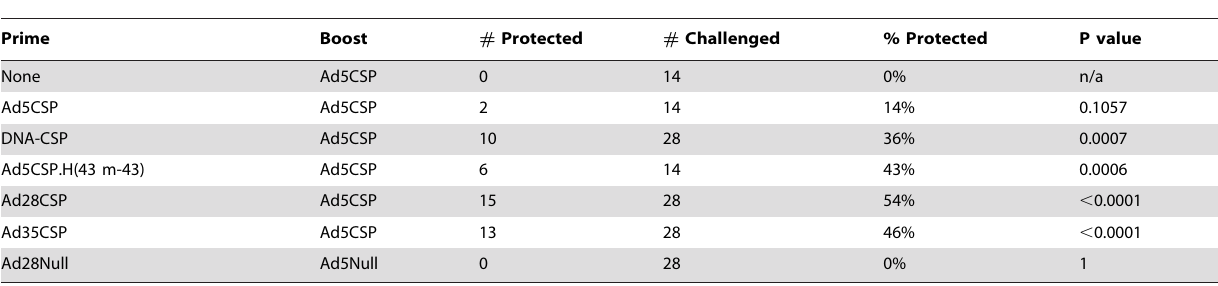
DNA dose=100 m g. Ad dose=1 6 10 9